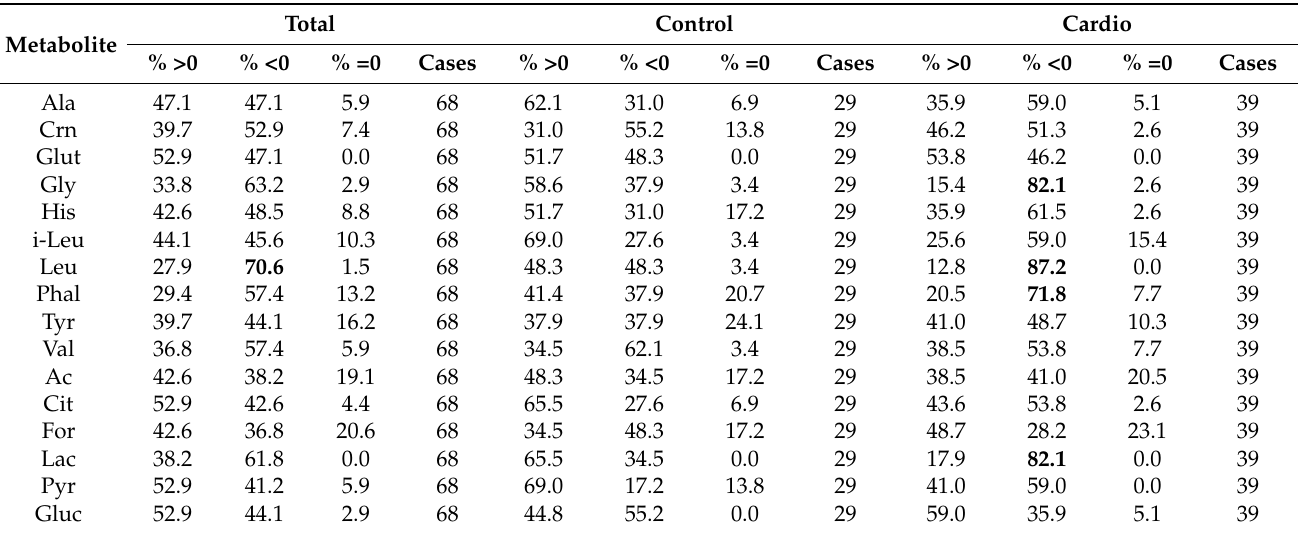
Table 1. Trends for small metabolites evolution after food intake. Significant changes (marked in bold) are considered when more than 70% of cases exhibit the same trend.